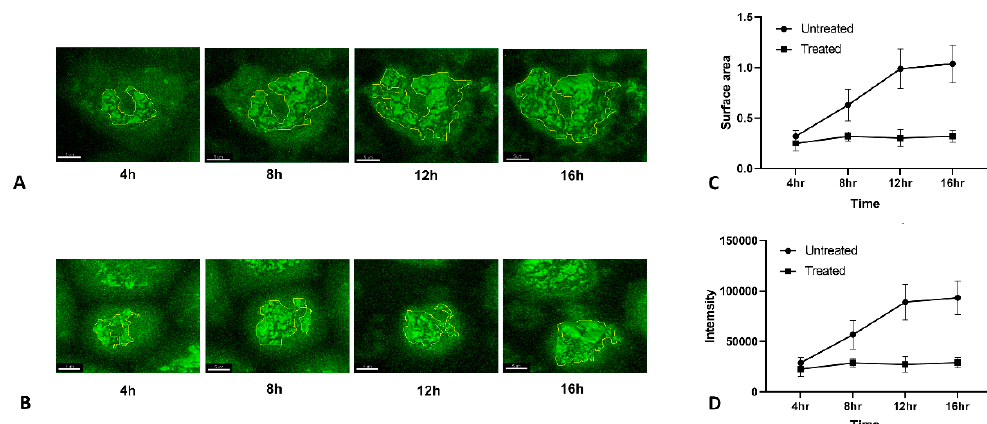
Figure 5. Live imaging of HA transport retardation by Tunicamycin ( A , B ) MDCK cells were infected with HA-TC PR8 IAV at MOI of 5. After 3 h post infection, HA staining was performed using FIAsh dye as described in methods. Live imaging was performed using confocal microscope. Z stacks were recorded at 10-min interval starting from 3 h up to 16 h post infection. Imaging data was analyzed and converted to a video using Imaris software. A shows imaging done in control condition, where B shows imaging done in presence of Tunicamycin at 2 µ M concentration. ( C , D ) The surface area and intensity of HA signal under control and drug treated condition at different time points was measured by using Imaris software. Values were recorded from 3 independent fields and mean ± SD were plotted on the graphs shown in the figure.